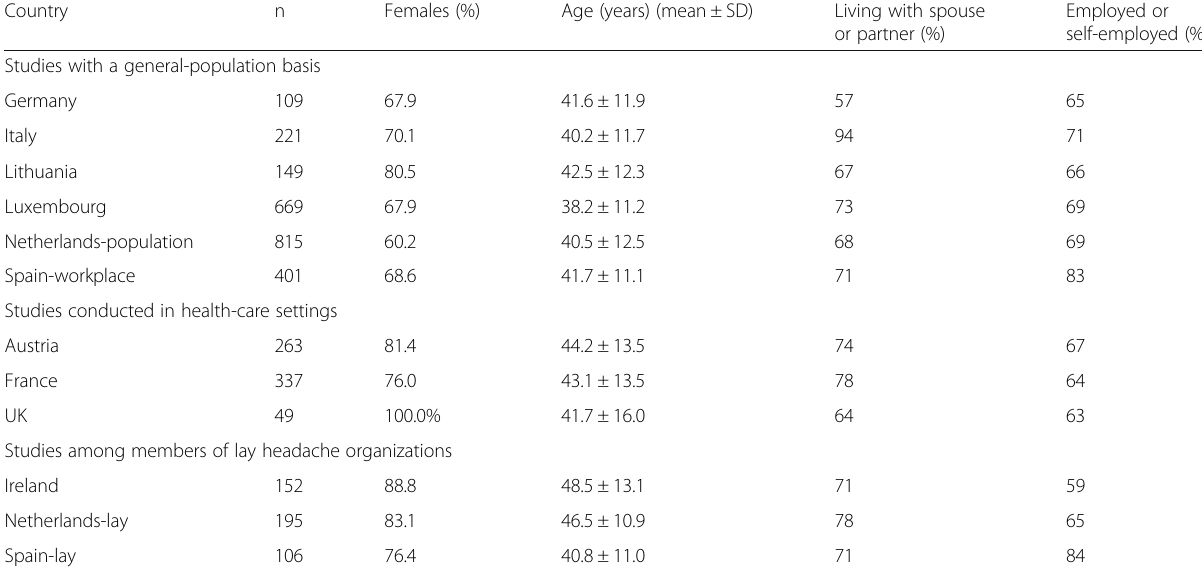
Table 2 Sociodemographic features of participants with migraine ( N = 3466) Country n Females (%) Age (years) (mean ± SD) Living with spouse